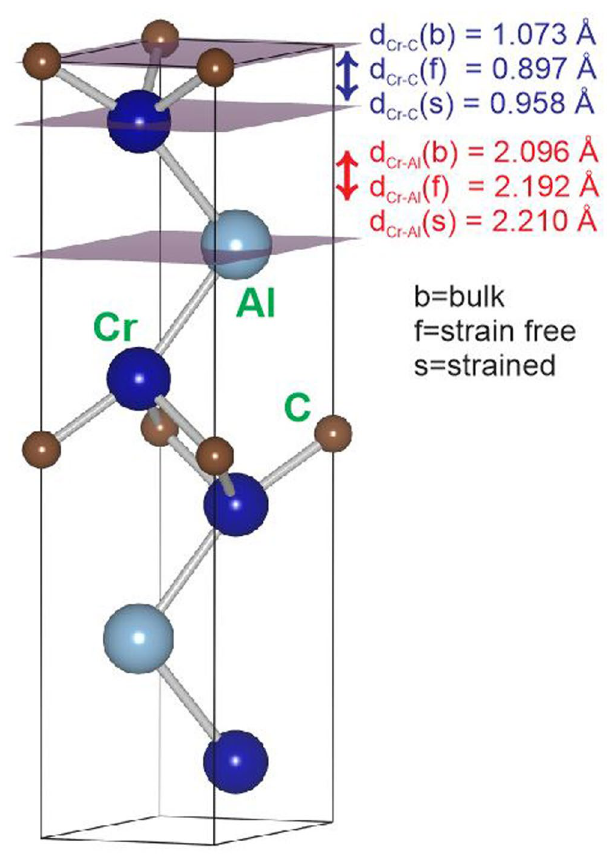
Figure 5. Unit cell of Cr 2 AlC with highlighted surface and two subsurface planes. Surface relaxations are described by the changes in the interplanar